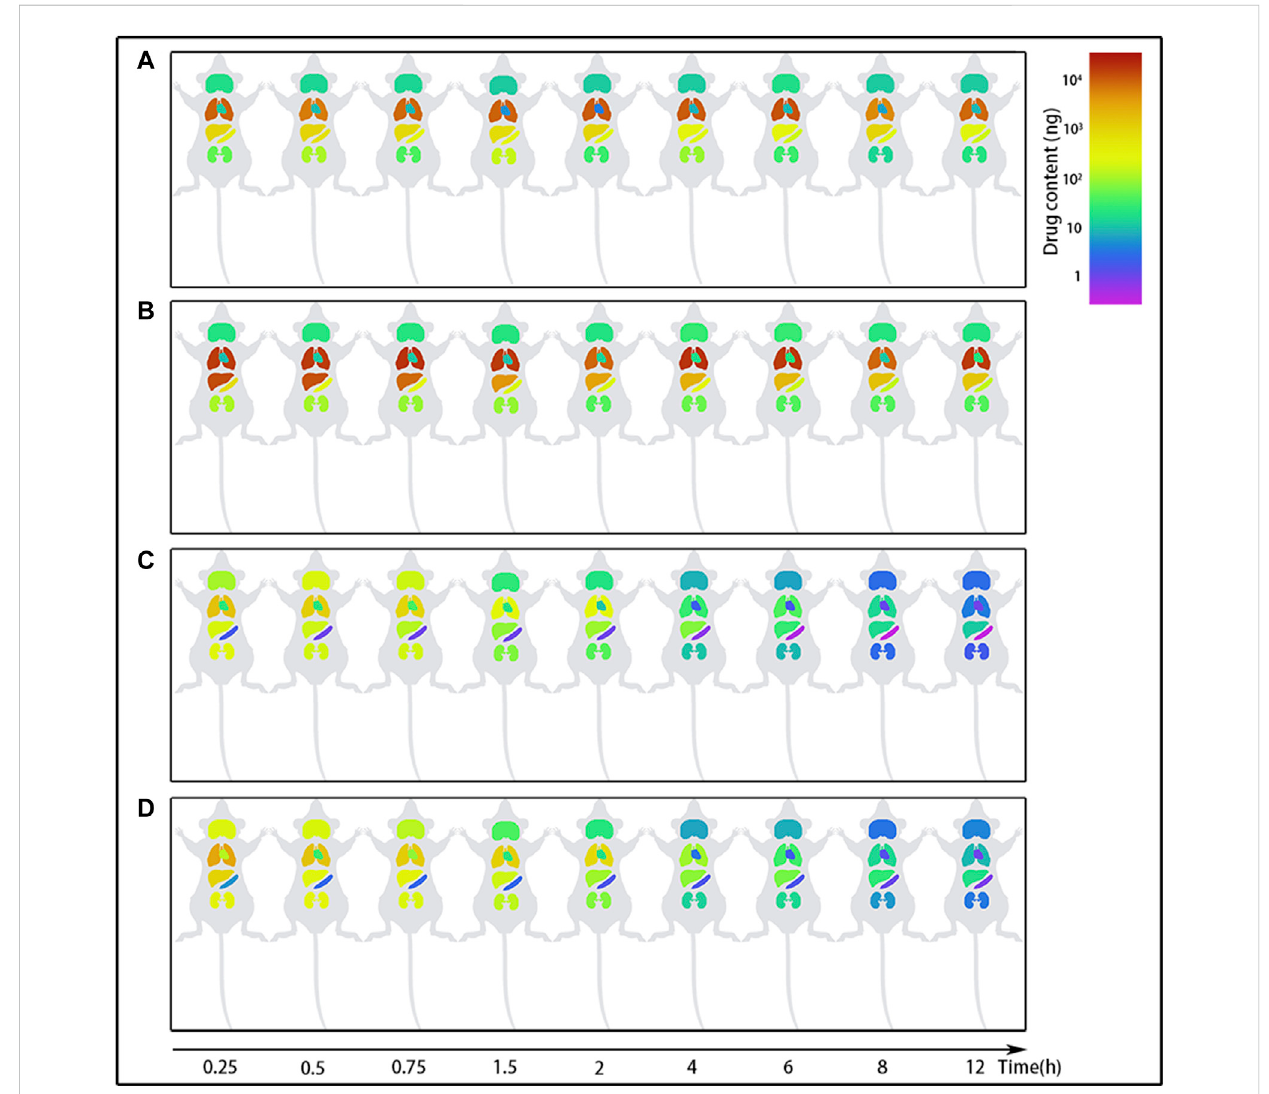
FIGURE 6 Thecontentchangesofevodiamine(EDM)anddehydroevodiamine(DEDM)intheorgansofmice.EDM(5,2.5 mg/kg)andDEDM(10,5 mg/kg)were administered to mice via the tail vein. The content of alkaloids in tissue was calculated by multiplying tissue concentration (at each time point) by the corresponding tissue weight. Tissue was collected at time points of 0.25, 0.5, 1, 2, 3, 4, 6, 8 and 12 h after dose (at each time point with 7 mice). Tissue concentration of alkaloids was then analyzed by HPLC-MS/MS. The mean ( n = 7) is provided for the following data: (A) EDM (2.5 mg/kg); (B) EDM (5 mg/kg); (C) DEDM (5 mg/kg); and (D) DEDM (10